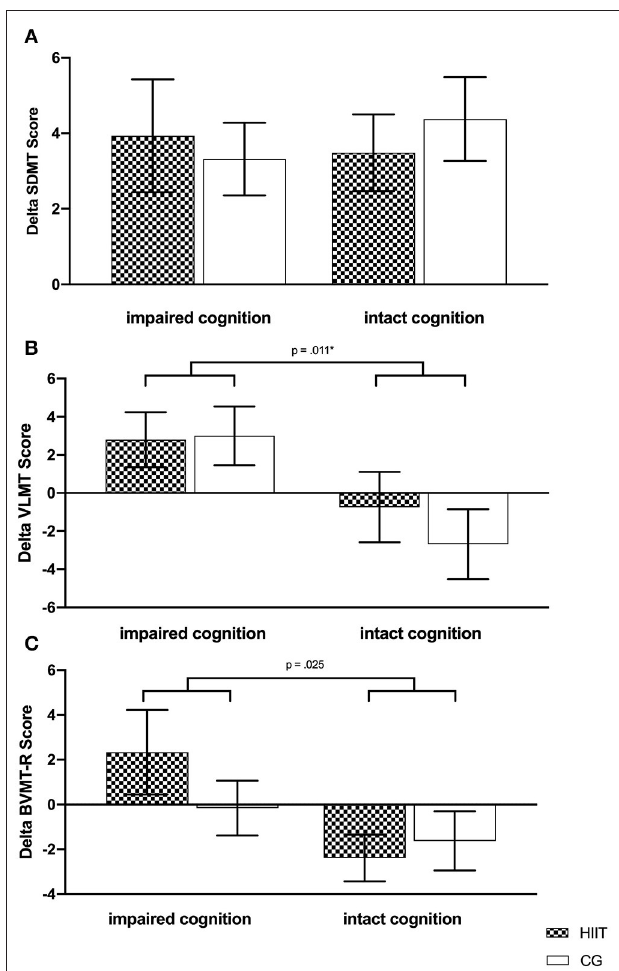
FIGURE 4 | Changes of cognitive performance parameters based on baseline cognition for the intervention (HIIT) and control group (CG). (A) SDMT, Symbol Digit Modalities Test; (B) VLMT, Verbal Learning Memory Test; (C) BVMT-R, Brief Visuospatial Memory Test-Revised. Deviation bars are shown as standard error. *Significant changes between groups of cognitive